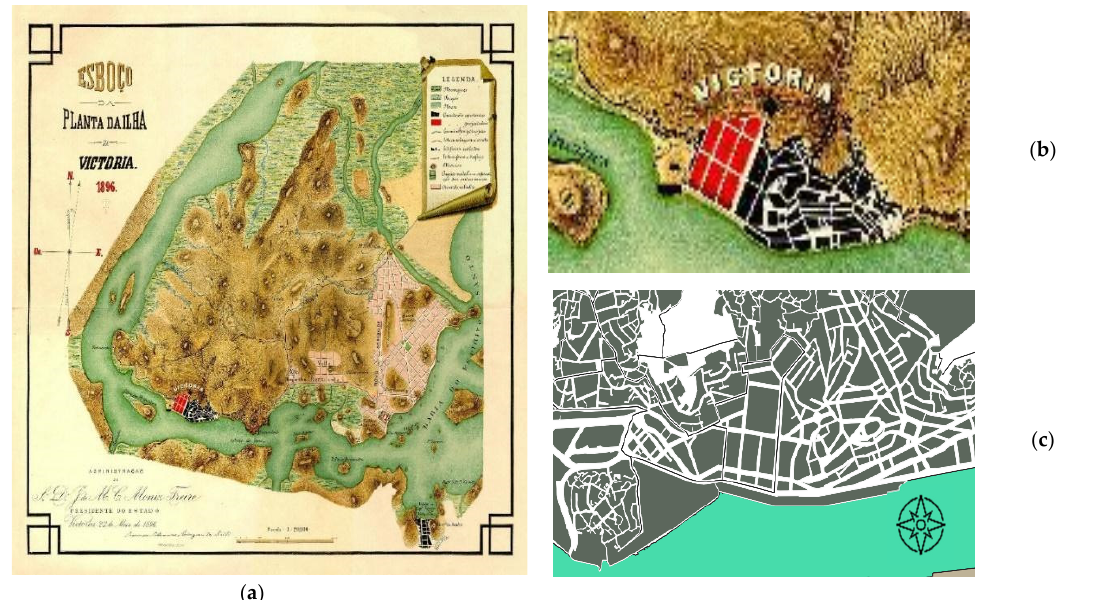
Figure 2. ( a ) Schematic plan of Vitória, from 1896 (black corresponds to its oldest occupation, red to the first embankments, and pink to the New Arrabalde Project for expansion; ( b ) Detail of the 1896 plan for the center of Vitória; ( c ) current morphology. Sources: ( a , b ): http://legado.vitoria.es.gov.br/baiadevitoria/ (accessed on 13 July 2021); ( c ): created by the authors, based on GeoWeb/PMV cartography [55].